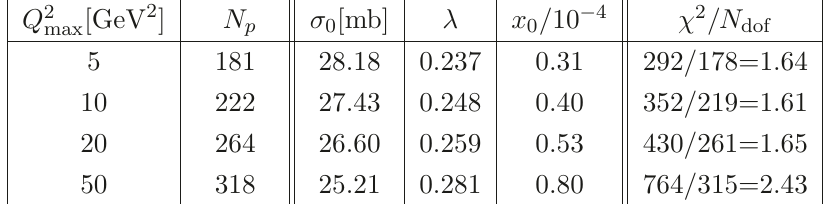
max in the data. N p is